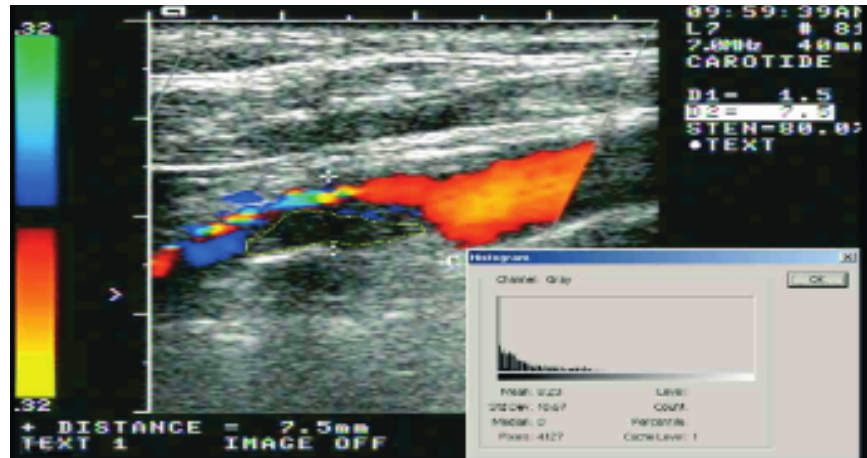
Figure 4 Anechogenic plaque with a low GSM value of 8. Notice also the low value of the standard devia- tion (10.6) correspon- ding to a homoge- neous plaque pattern (from our ultrasound